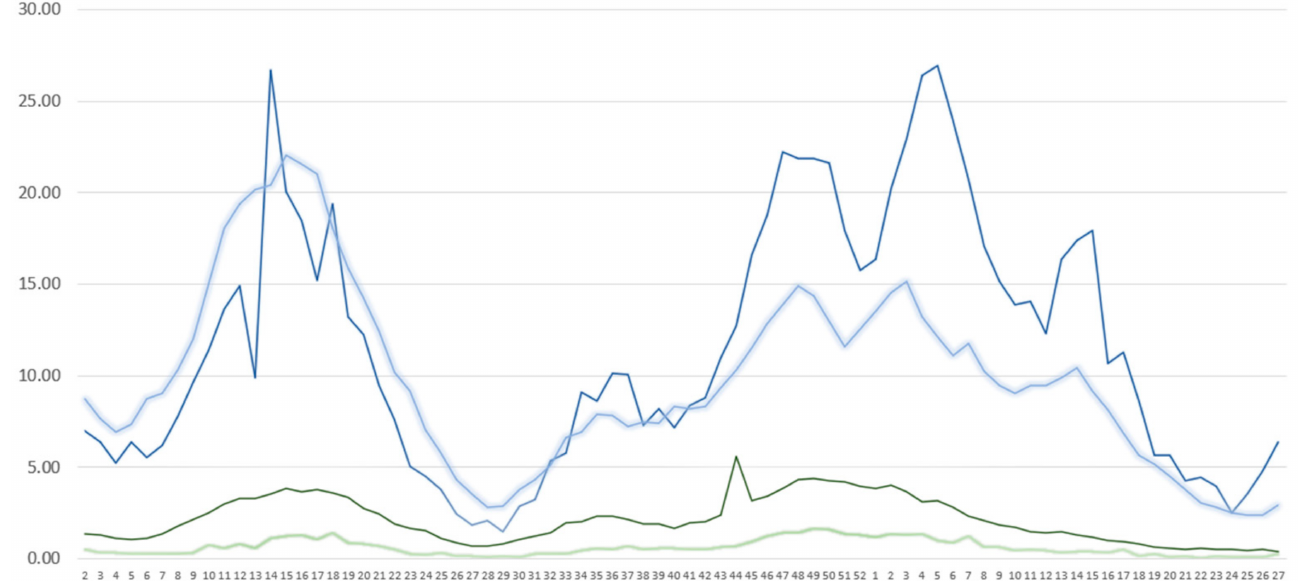
Figure 2. Absolute number of weekly COVID-19-related ICU admissions and COVID-19-related deaths in subjects <70 and ≥ 70 years. Data are expressed per 100,000 population. X axis presents the number of